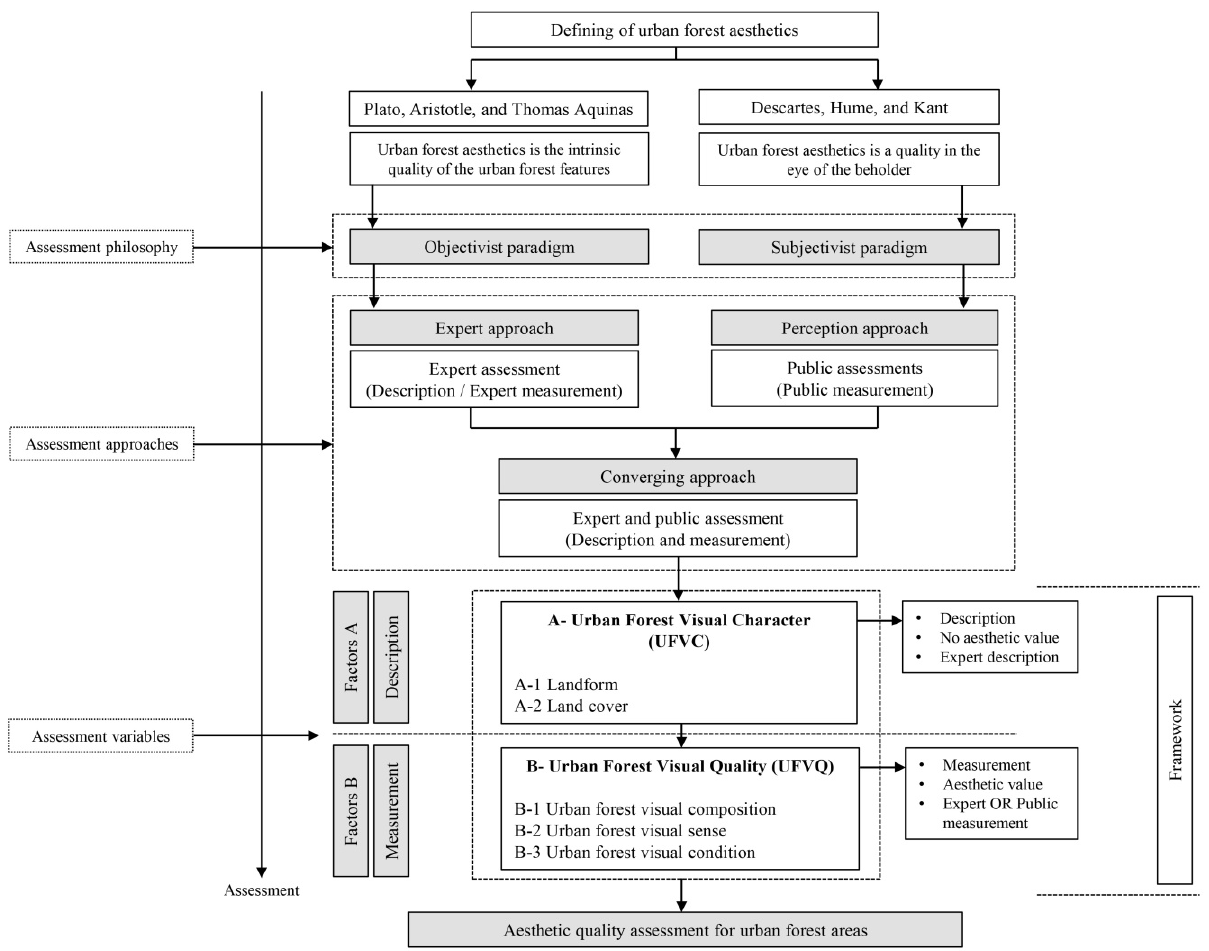
Figure 1. A flow of information to get an integrated framework for visual aesthetic quality assessment of urban forest areas. Reprinted from [2].